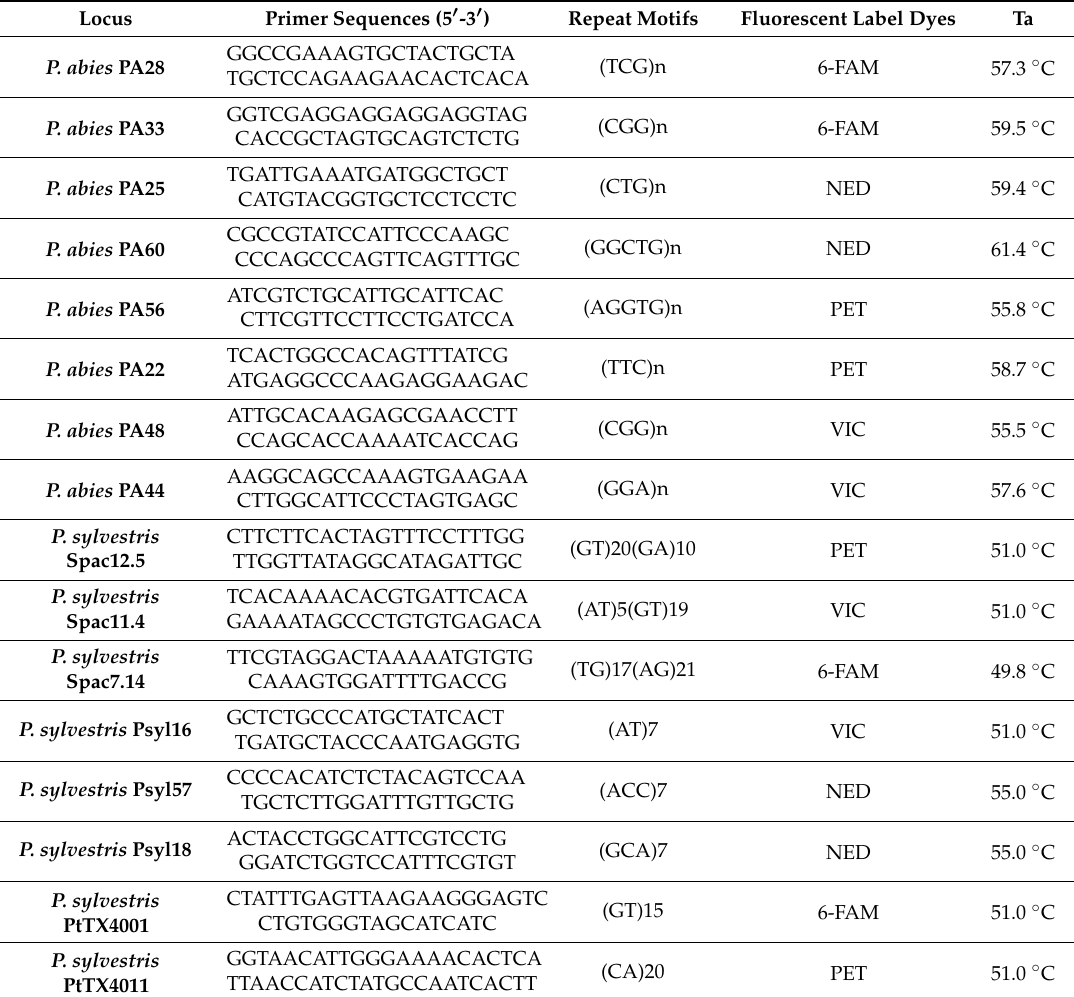
Table 1. Analysed loci of Norway spruce ( Picea abies (L.) H. Karst) and Scots pine ( Pinus sylvestris L.), sequences of microsatellite primers, repeat motifs, used fluorescent labelling dyes and specific primer annealing temperatures